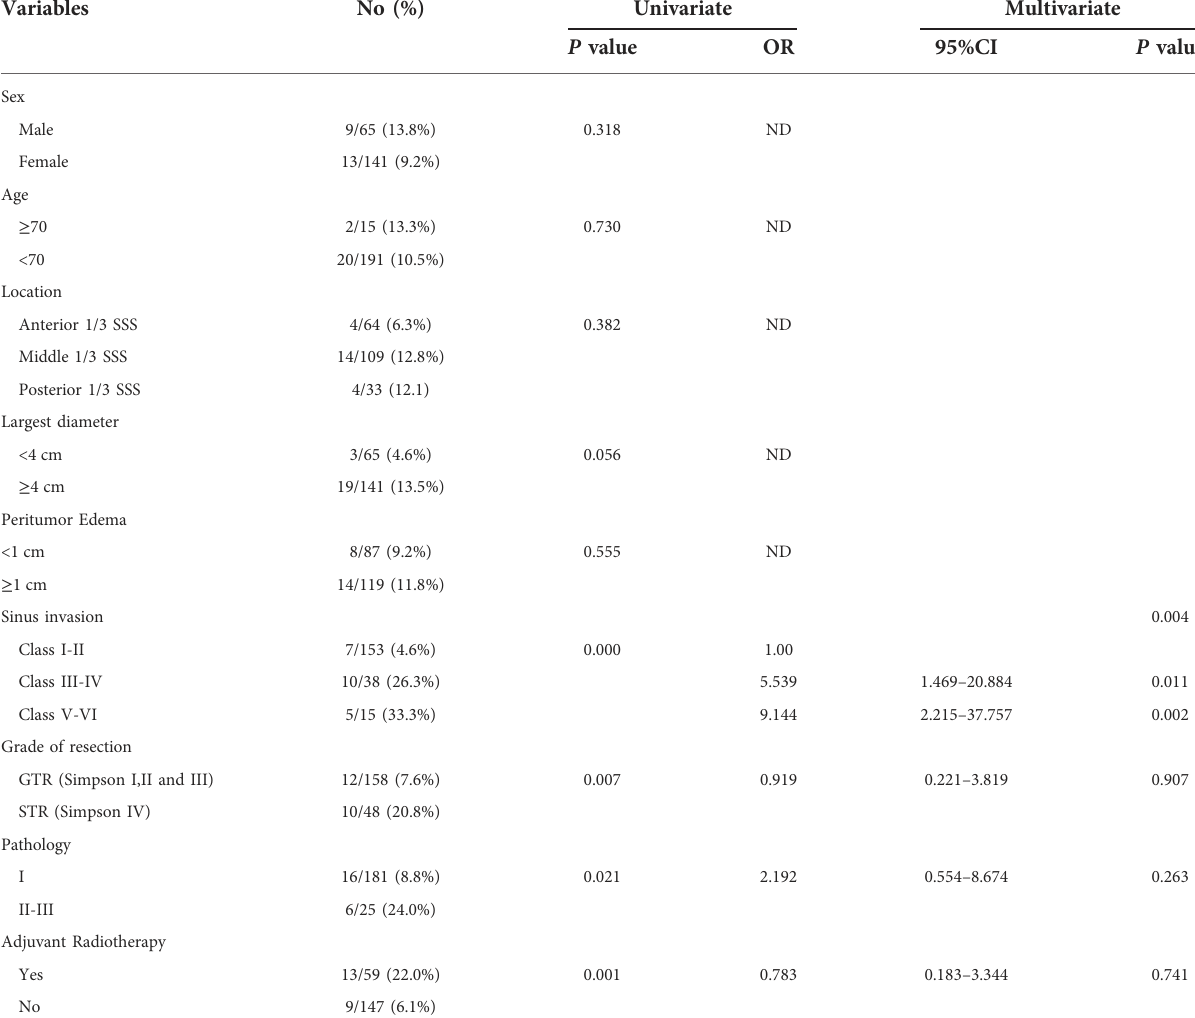
TABLE 4 Predictive factors of 206 patients with parasagittal meningiomas having recurrence based on the univariate and multivariate analyses.